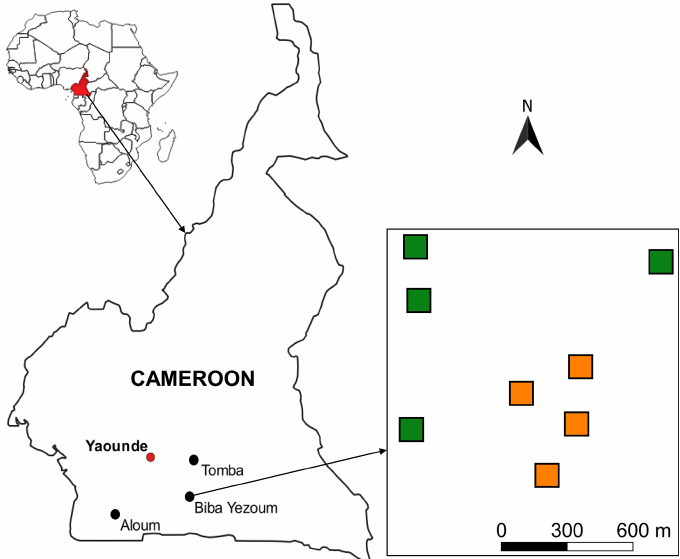
Figure B1. Location of the study sites in Cameroon, showing the four replicate plots per land use (green for forests and orange for cacao agroforestry) at one site.